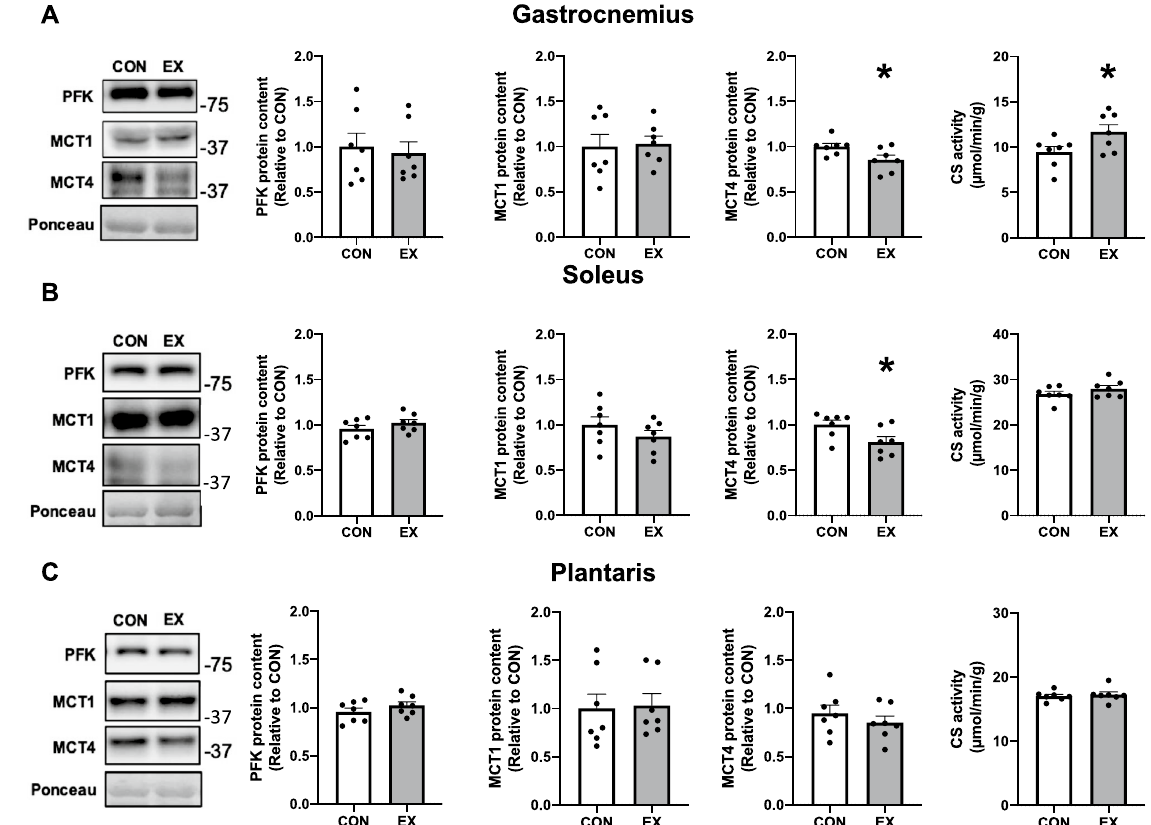
Figure 3. Effect of 6-week endurance exercise training on the PFK and MCT proteins and CS activity in the gastrocnemius ( A ), soleus ( B ), and plantaris ( C ) muscles. Data are expressed as mean ± SEM. n = 7 in each group. *P <